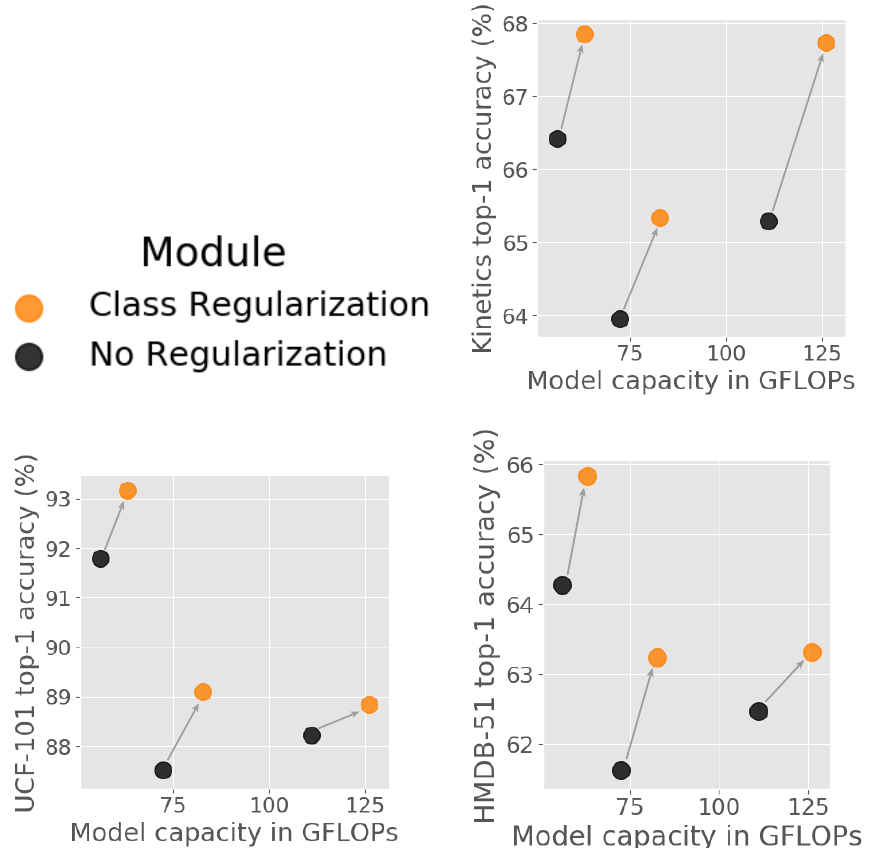
Figure 4. Class Regularization accuracy/computation